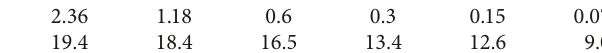
Table 5: The gradation of